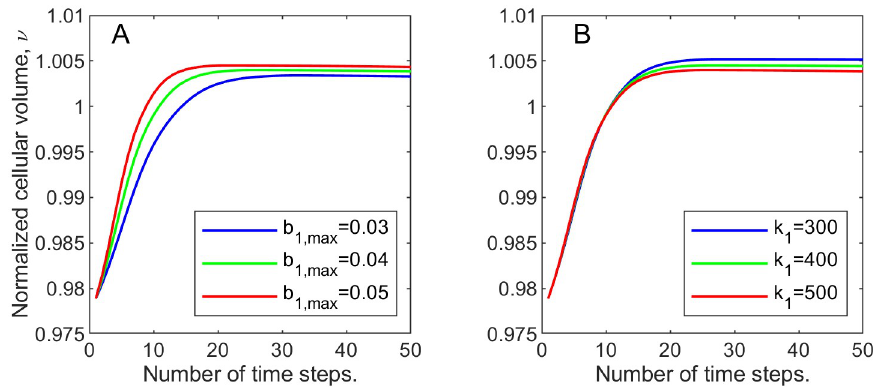
Fig 3. Normalized cellular volume, ν , changing with time. A: varying maximal cellular growth rate parameter, b 1,max ; B: varying strain parameter k 1 for the cellular volume fraction.